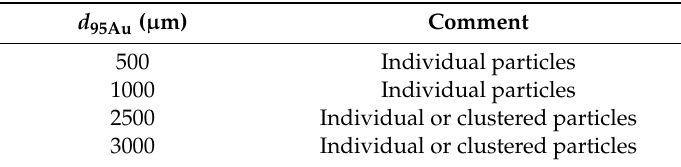
Table 6. Range of potential d 95Au values for BCOG.